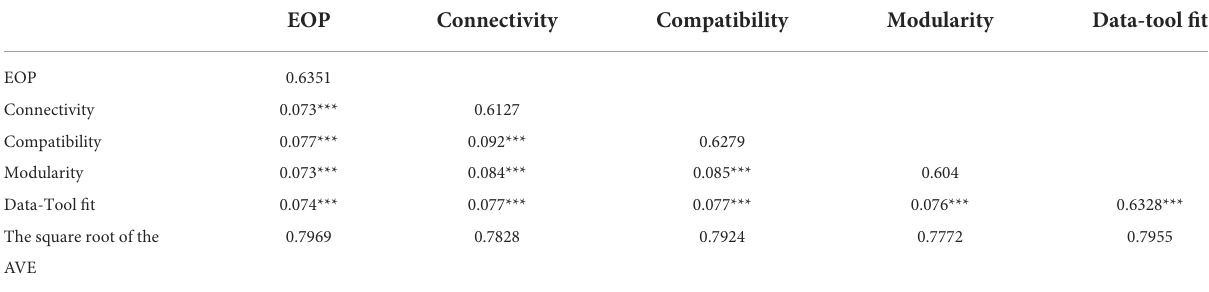
TABLE 6 Discriminant